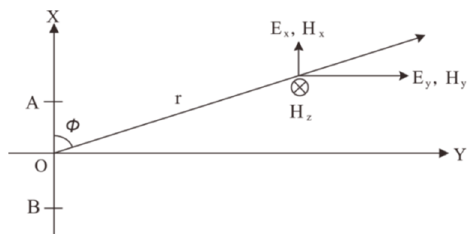
Figure 3. EMF Components Measured by the CSAMT and Coordinate System.